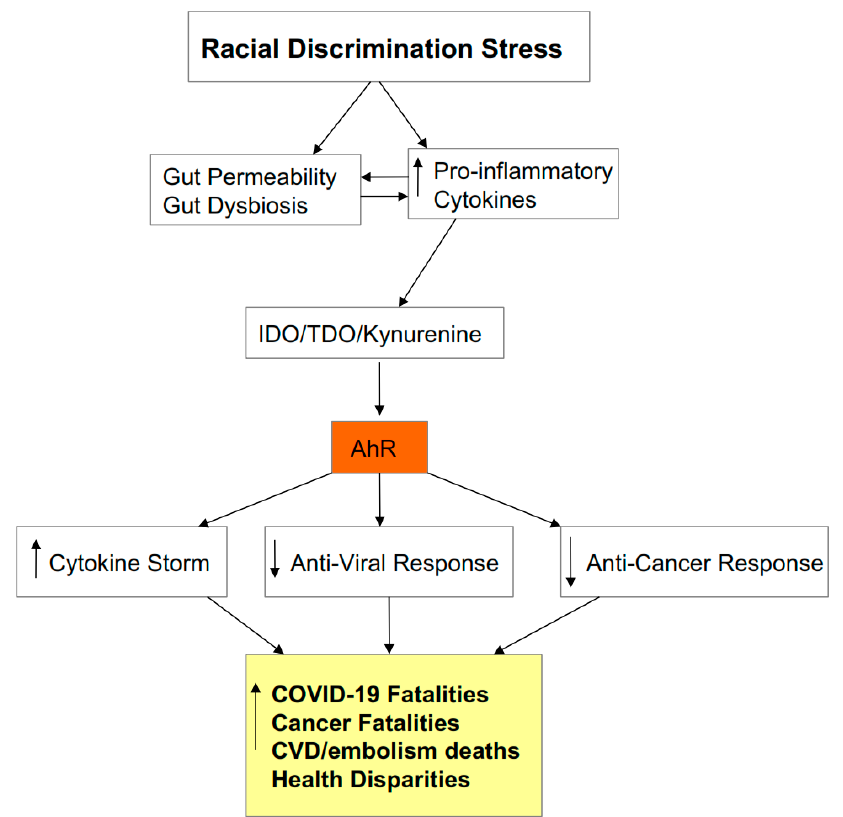
Figure 7. Racial discrimination is associated with increased basal and induced pro-inflammatory cytokines, driving IDO induction of kynurenine, and thereby leading to AhR activation that acts